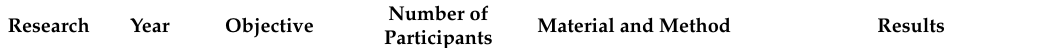
Table 5. The main effects of COVID-19 on the urinary